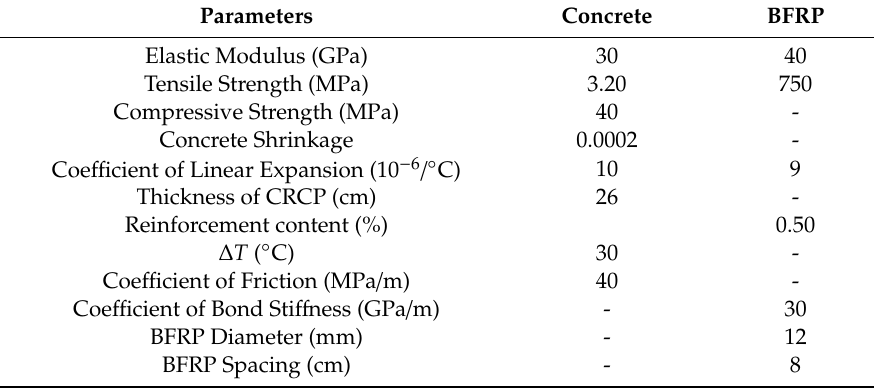
Table 3. Input parameters for the BFRP-CRCP test section for the analytical